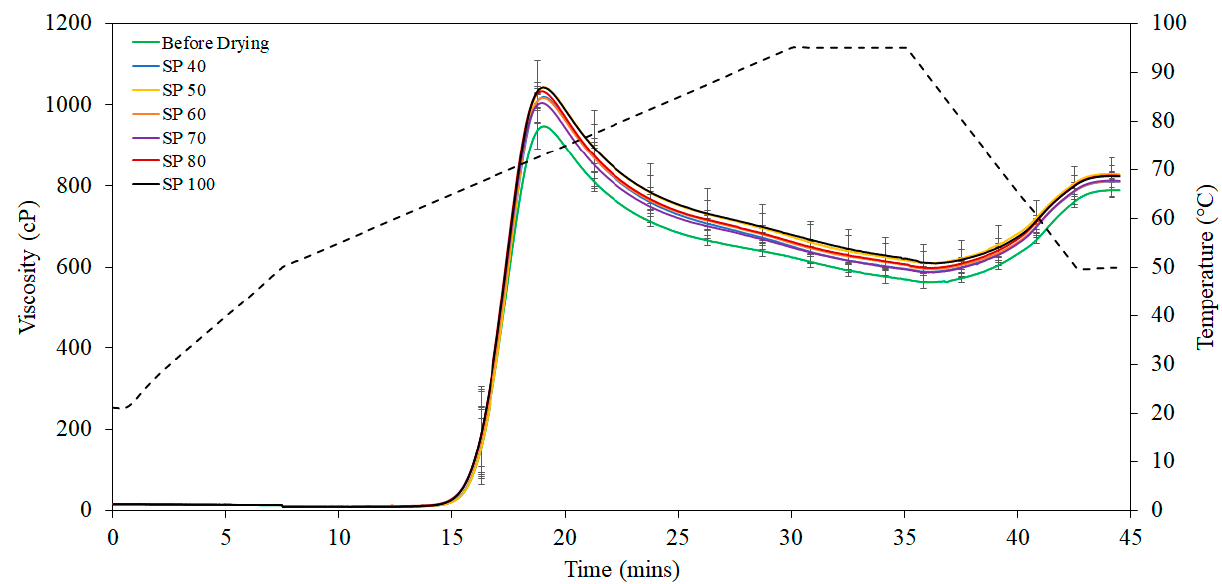
Figure 2. Pasting profile of native and spray dried waxy rice starches.